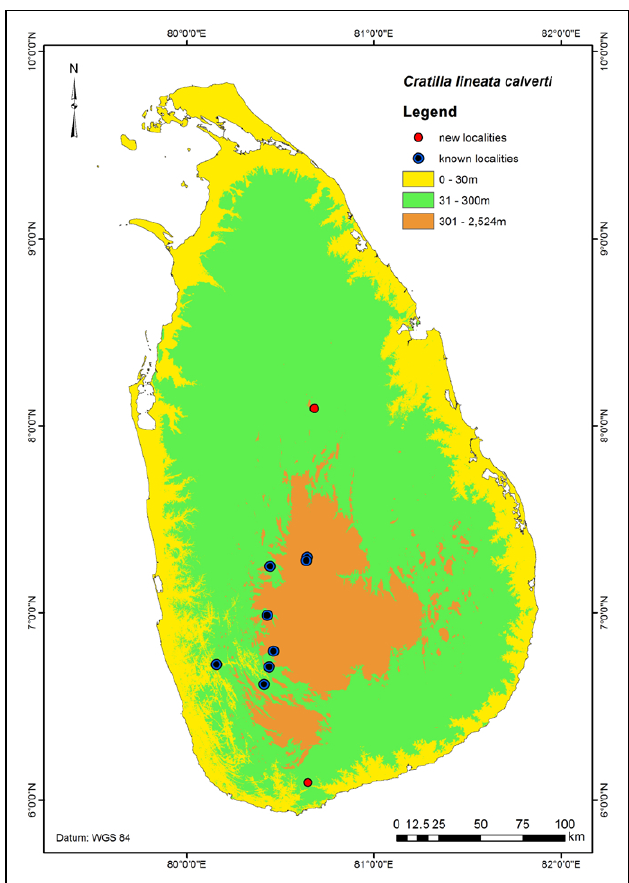
Figure 20. Distribution of Cratilla lineata calverti in Sri Lanka with new